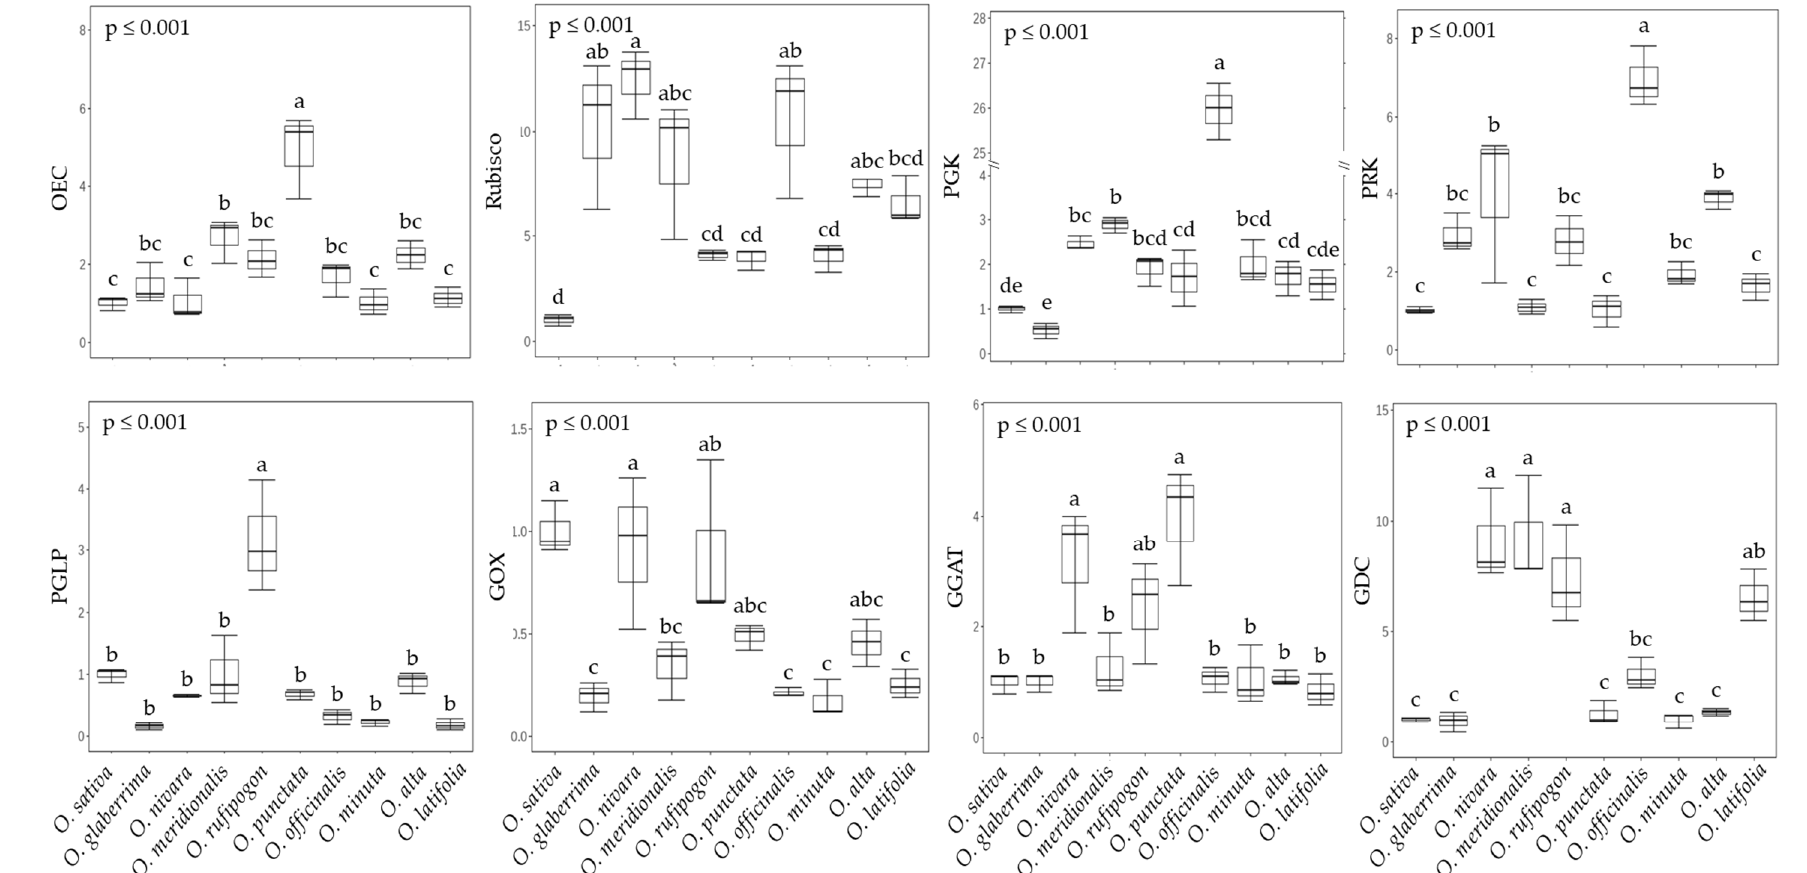
Figure 4. Comparison of relative gene expression encoding several major enzymes associated with photosynthesis and photorespiration between wild rice species at 60 DAT (mean of three replications ± S.D.). Means followed by different letters in the same raw are significantly different at p < 0.05 according to Tukey’s HSD test. OEC, oxygen-evolving complex; Rubisco, rubisco-1,5-bisphosphate carboxylase/oxygenase; PGK, phosphoglycerate kinase; PRK, phosphoribulo kinase; PGLP, phosphoglycolate phosphatase; GOX, glycolate oxidase; GGAT, glutamate glyoxylate aminotransferase; GDC, glycine decarboxylase.